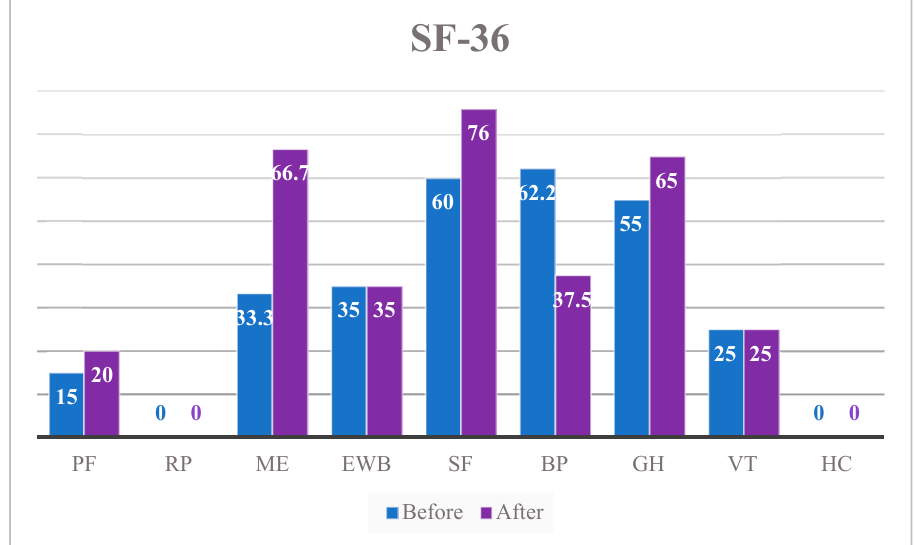
Figure 6. Trend of the SF-36.